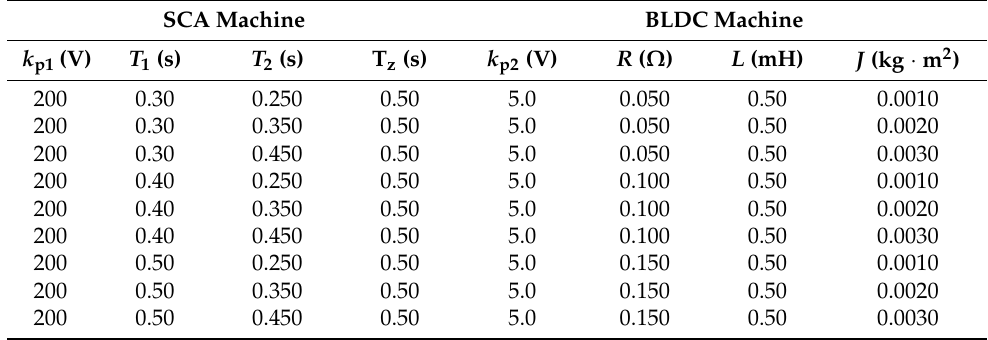
Table 2. Parameters selected for the IRN